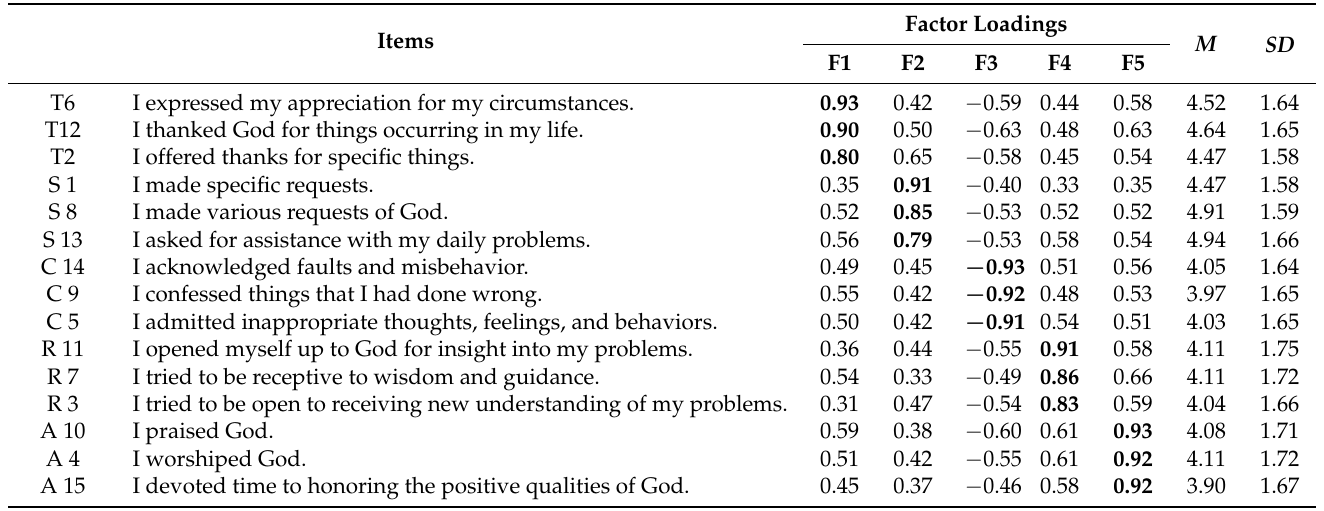
Table 1. Exploratory Factor Analysis Showing 15 Items and Factor Loadings from the Pattern Matrix (Principal Component Analysis with Oblimin